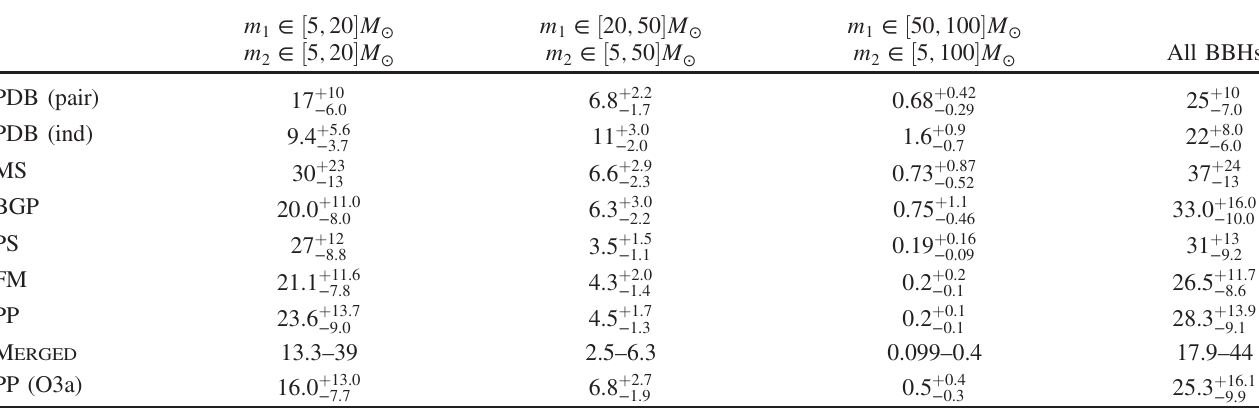
TABLE XVI. Merger rates in Gpc − 3 yr − 1 for black hole binaries quoted at the 90% credible interval. Rates are given for three ranges of primary mass m 1 , as well as for the entire population. The PDB, MS, and BGP merger rates are derived assuming the merger rate does not increase with redshift, using a threshold FAR < 0 . 25 yr − 1 (Sec. IV). For FM, PS, and PP, merger rates are reported at z ¼ 0 . 2 estimated using a threshold FAR < 1 yr − 1 (Sec. VI). The merged rates reported in the M ERGED row are the union of the preceding three rows, which all account for distance-dependent merger rate and adopt a consistent threshold. The final row shows merger rates deduced from our analysis of GWTC-2 [20], which assumed a redshift-independent merger rate. Compare to Table IV. m 1 ∈ ½ 5 ; 20 (cid:2) M